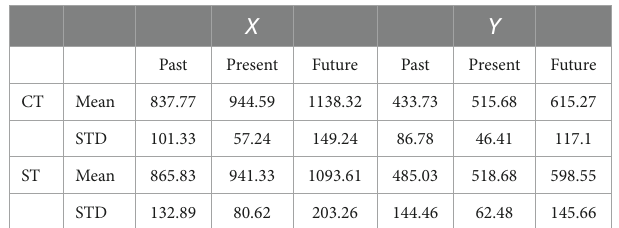
TABLE 2 Mean and STD values of X and Y